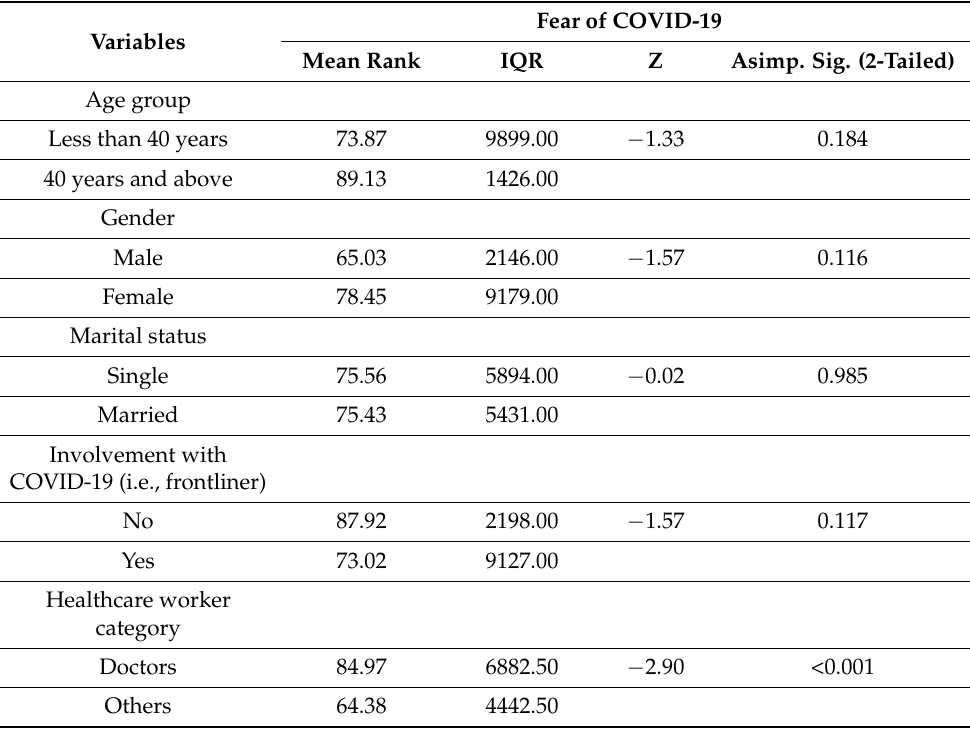
Table 2. Fear toward COVID-19 based on the demographic characteristics of the healthcare workers (HCWs) enrolled in the